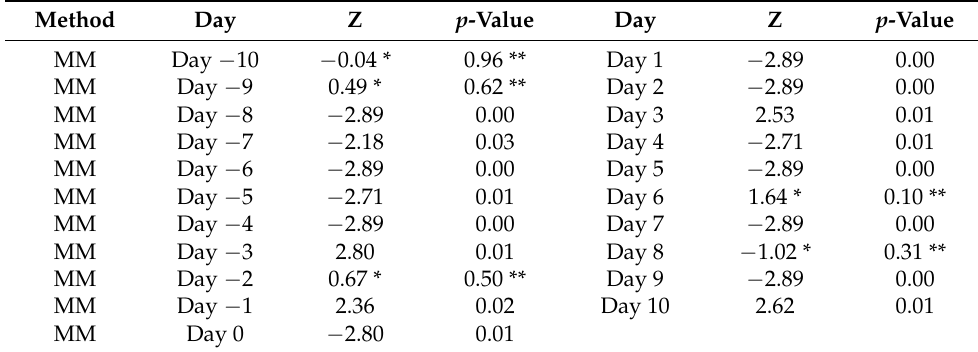
Table 7. Wilcoxon signed-rank test, MM